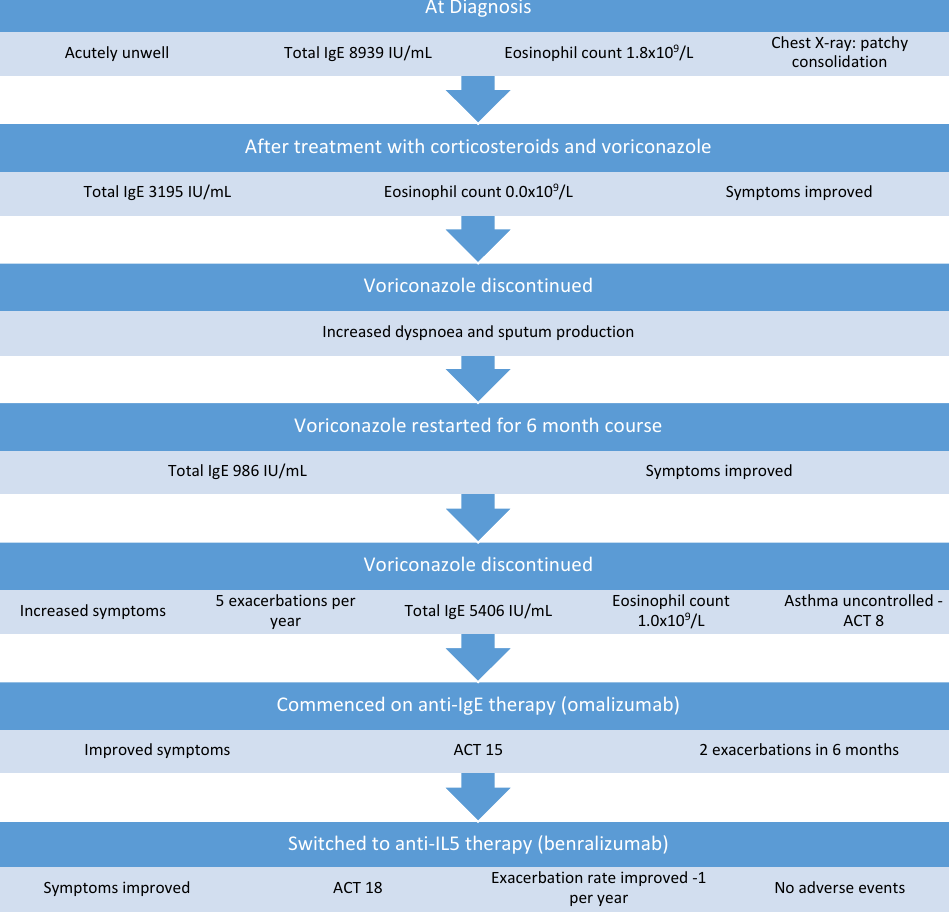
Figure 3. Management of Case 3.